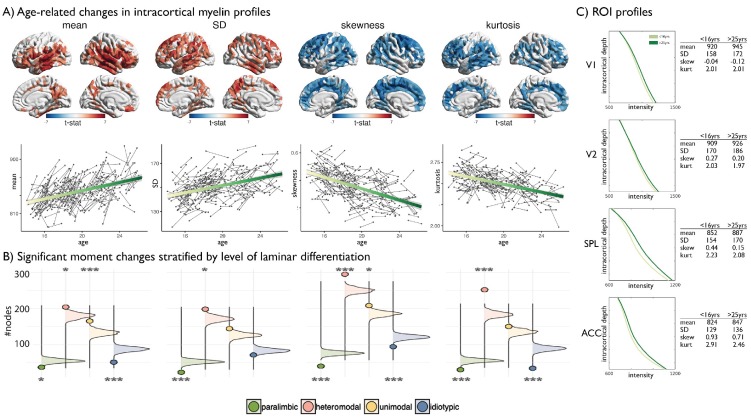
Age-related changes in SD and kurtosis.(A) Upper t-statistics projected on the cortical surfaces depict significant age-related changes in MT moments. Lower Scatter plots depict individual changes in average moment value across significant regions, with regression lines depicting the age-related changes. SD showed a steady increase during adolescence and preferentially impacted heteromodal cortices (z = 3.42, p=0.012), while paralimbic cortex was under-represented (z = −5.60, p<0.001) as assessed using spin premutation and count tables of significant regions per class of laminar differentiation. Kurtosis showed a steady and robust decrease during adolescent development that preferentially affected heteromodal cortex (z = 8.80, p<0.001). (B) Bar plots show the z-scores of the number of regions passing FDR correction for each class relative to a null-distribution generated from spin permutations of the t-statistic map (Alexander-Bloch et al., 2018). Significance is indicated by asterixis and based on Bonferroni corrected p-values across all moments and classes (***=p < 0.001, *=p < 0.05). Positive significant z-scores indicate that the number of regions passing FDR for that class are significantly higher than expected by chance, negative significant z-scores indicate the number is significantly lower (tables provided below).